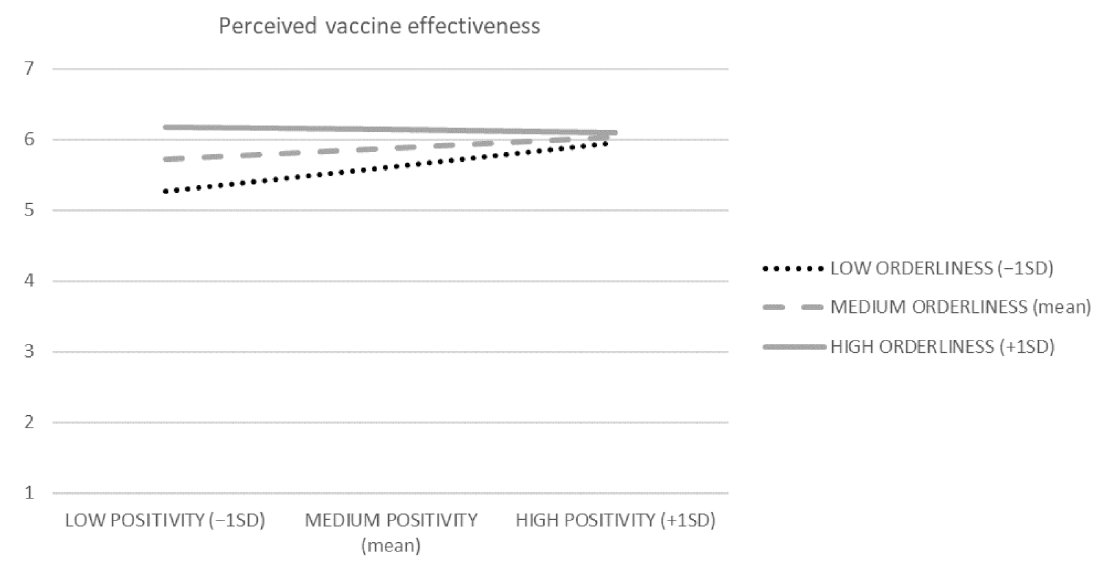
Figure 3. Visualization of the conditional effects of belief in the world’s positivity on perceived vaccine effectiveness (belief in the world’s orderliness is the